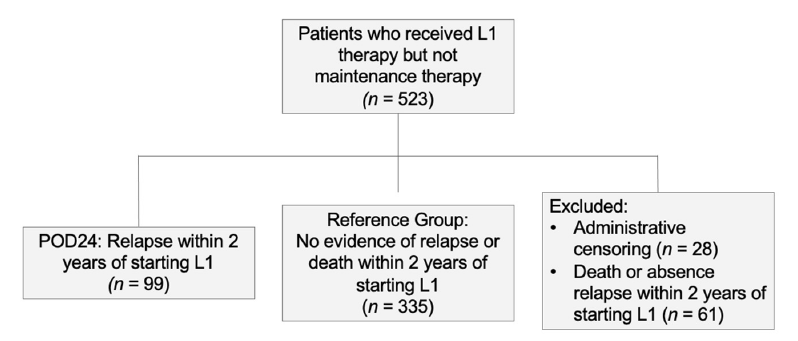
Figure 2. Participant selection diagram for Cox model with curated + POD24 dataset. L1: first-line treatment; POD24: progression of disease within 24 months of initiation of first-line treatment.